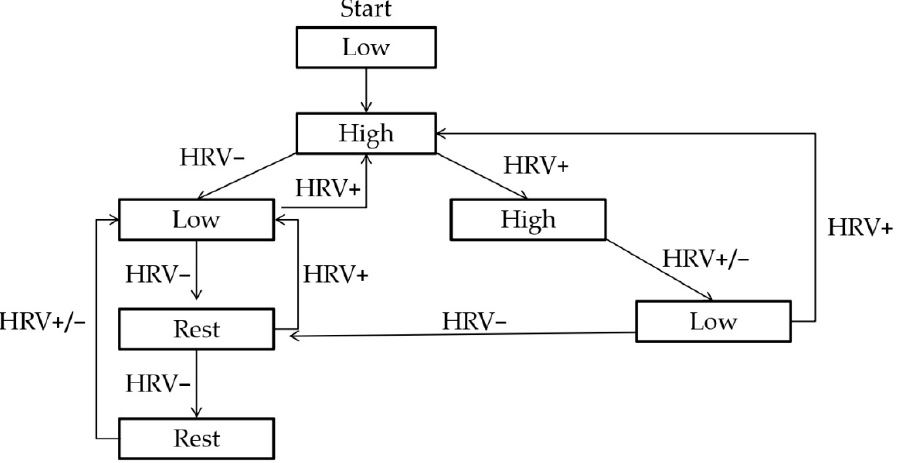
Figure 1. HRV-guided training schema [36]. When LnrMSSD7-d is within the normal range, high- intensity training sessions will be prescribed. If LnrMSSD7-d falls below the normal range, low intensity or rest will be prescribed. Low = exercise at 65% of maximal heart rate, High = exercise at 85% more of maximal heart rate, Rest = resting day, HRV+ = increased or unchanged HRV; HRV − = decreased HRV.